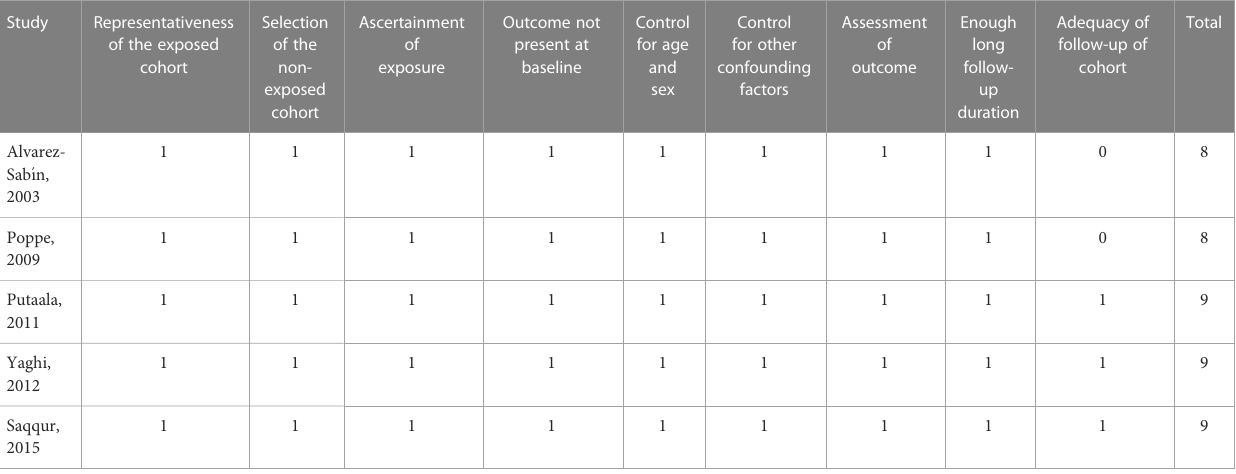
NOS: Newcastle-Ottawa